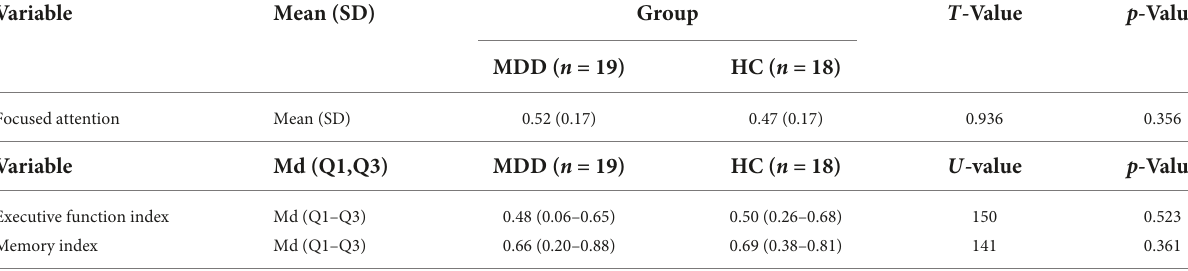
TABLE 4 Comparison between MDD and HC group on neurocognitive indices.